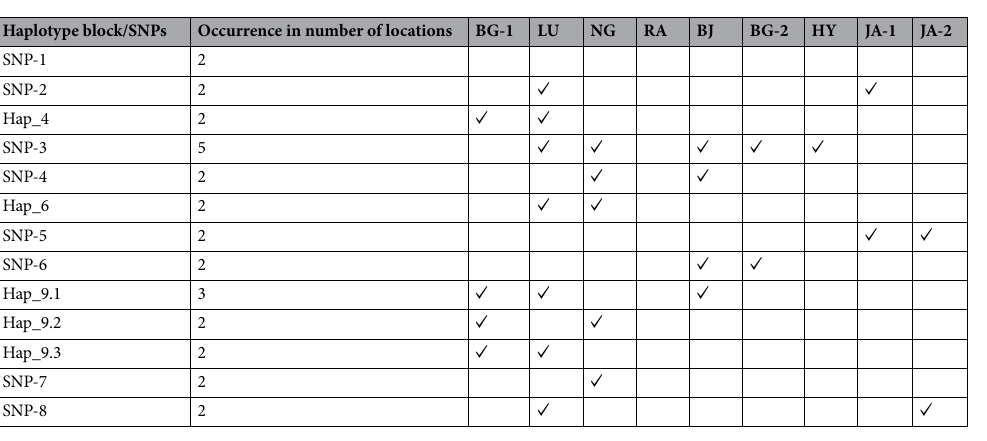
Table 5. Number of significantly associated SNPs and haplotypes common in two and more locations.